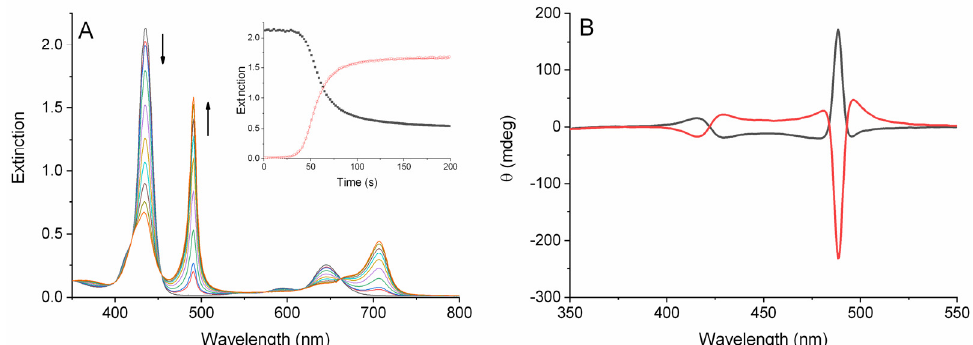
Figure 1. ( A ) UV/Vis extinction spectral changes and relative kinetic profiles (inset) at 492 nm (red trace) and 434 nm (black trace) for the aggregation of TPPS 4 induced by adopting the modified PF mixing order protocol (see text) in the presence of L-Ser. Experimental conditions: [TPPS 4 ] = 10 μ M; [H 2 SO 4 ] = 0.5 M; [L-Ser] = 0.1 M, T = 298 K, cell path length 0.5 cm. The solid lines are the best-fitting of the experimental extinction data to Equation (1) (see text). ( B ) CD spectra for the final aggregated samples obtained in the presence of L (red trace) and D-Ser (black